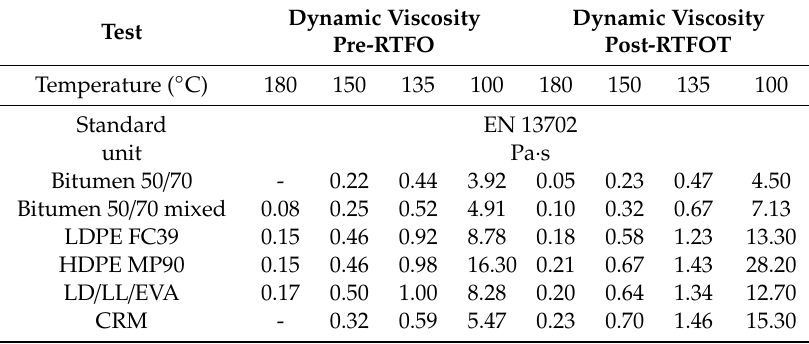
Dynamic Viscosity